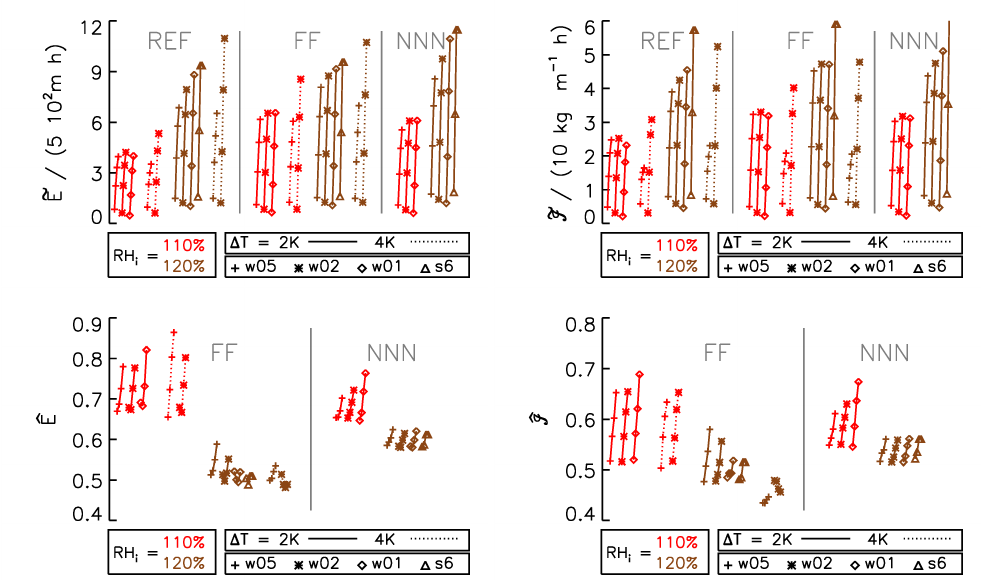
Figure 8. The extent of saturation in formation flight scenario is illustrated. Displayed are the time-integrated total extinction and total ice mass for lifetimes of 2, 4, 6 and 8 h along each curve. Top row: absolute values ˜ X , bottom row: normalised values ˆ X ; The symbols show absolute values for each of the REF, FF and NNN simulations (from left to right). The different symbols show various atmospheric scenarios (see symbols in legend) with RH i,0 ∗ = 110% (red) or 120% (brown). The solid/dotted lines show scenarios with ∆ T = 2K and 4K, respectively. The set of scenarios is as in Figure 7. Each curve connects four identical symbols and is slightly slanted as the four symbols have a small horizontal offset. For each curve the integration time increases from left to right.